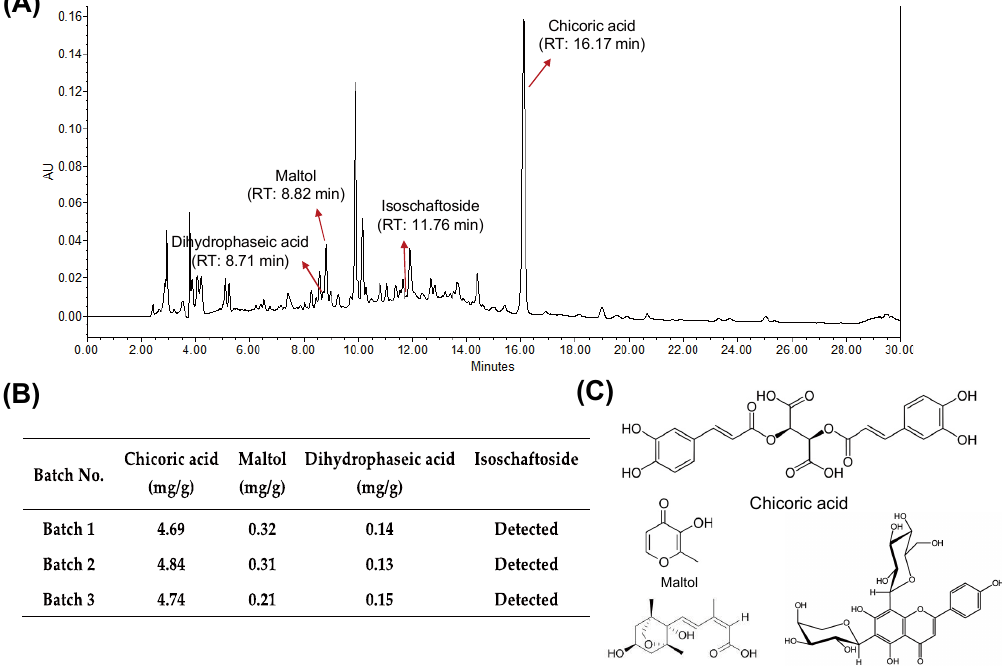
Figure 1. Preparation of HX109 was standardized using marker compounds. HX109 was dissolved in 50% methanol at a concentration of 20 mg/mL and subjected to HPLC analysis. ( A ) Representative HPLC chromatogram of HX109. HPLC was performed as described in the Materials and Methods section. The marker compounds in HX109 were identified by comparison with the reference standard and the peaks of marker compounds are indicated by arrows. RT, retention time. ( B ) Quantification of marker compounds in HX109. ( C ) Molecular structure of marker compounds.